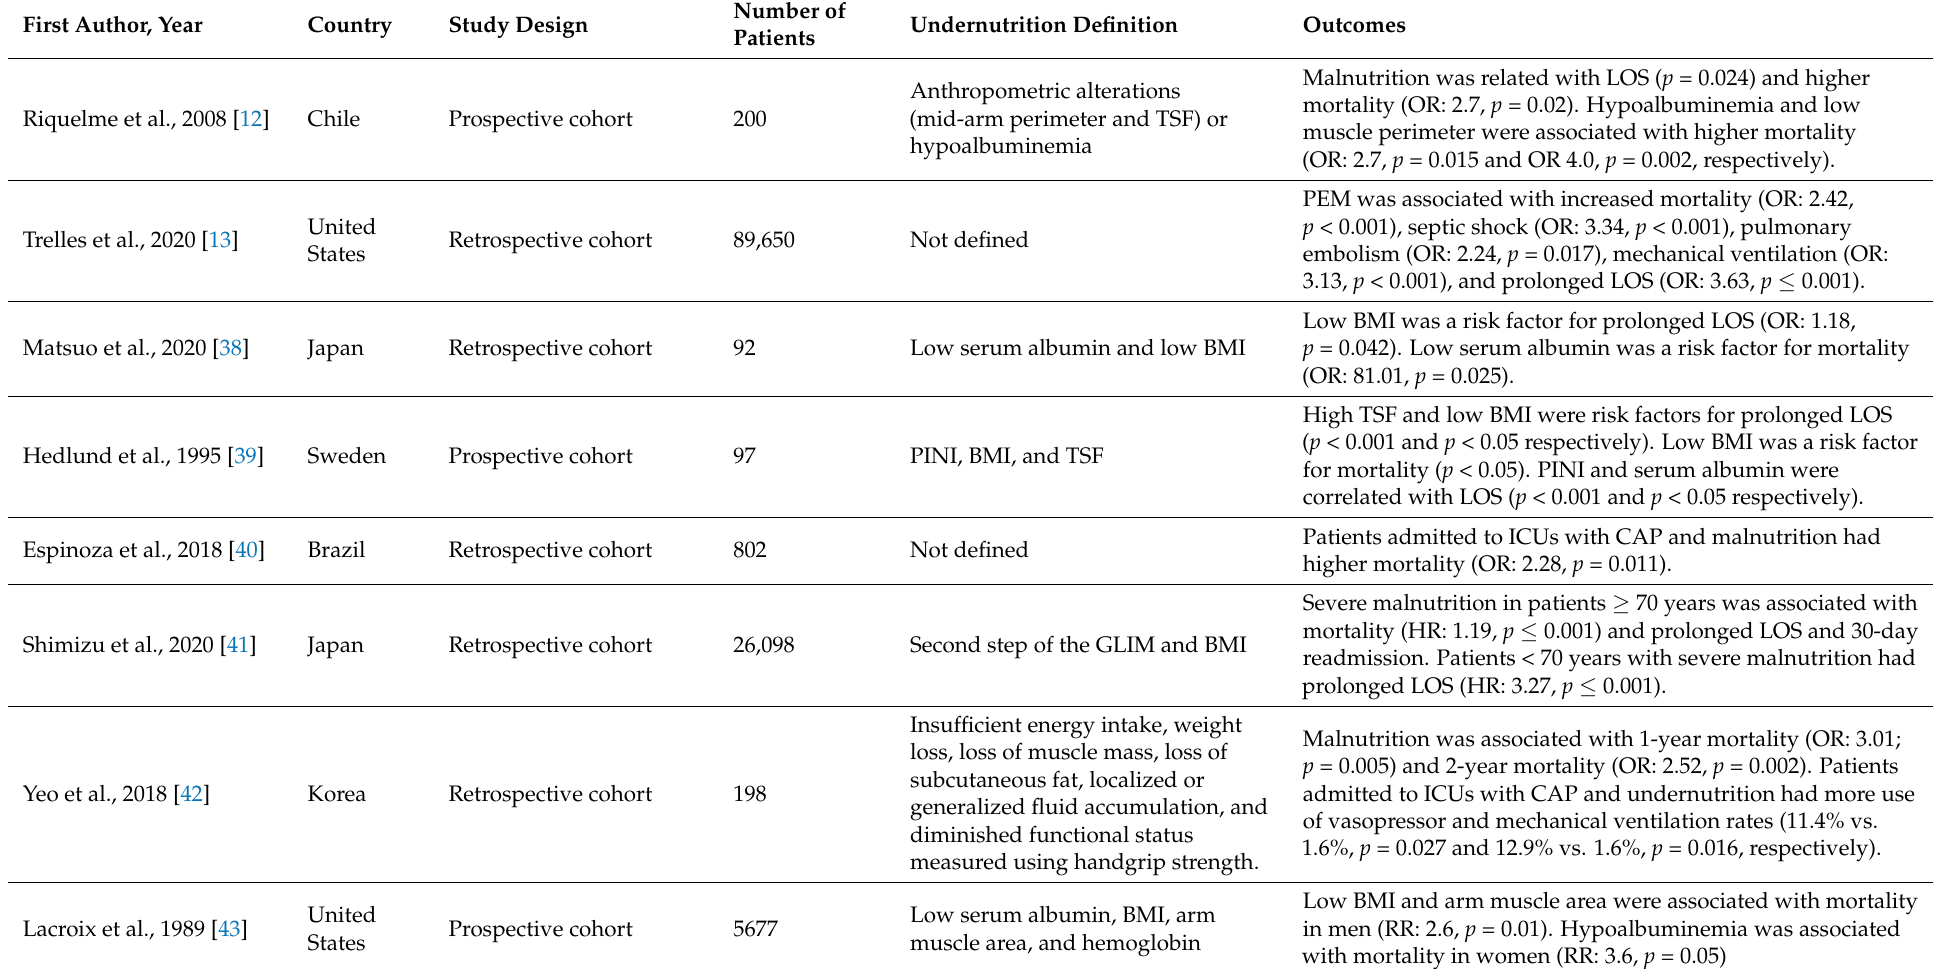
Table 1. Summary of studies on prognosis of CAP and